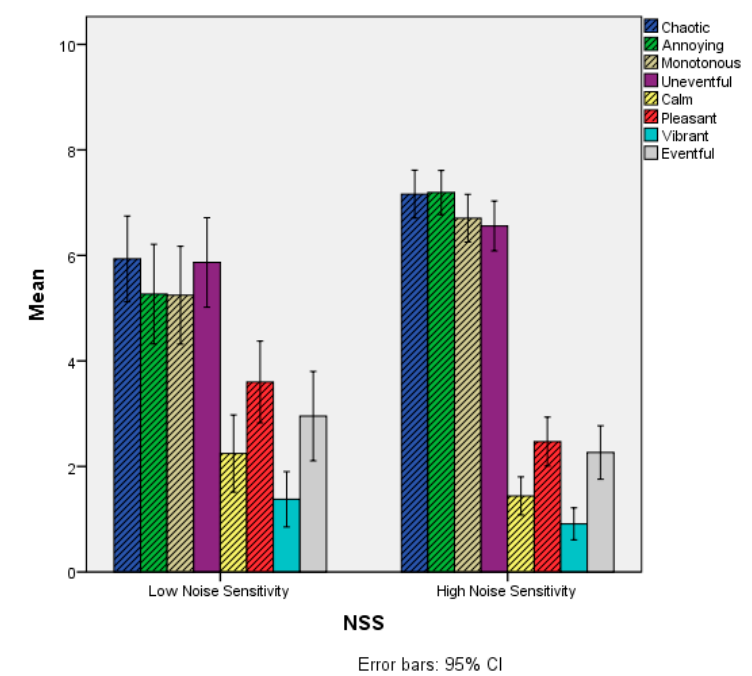
Figure 5. Mean scores of the Soundscape appraisal items as a function of the NSS variable. Grey-shaded bars refer to items where statistically significant differences were observed between the two groups. NSS: Noise Sensitivity Scale.